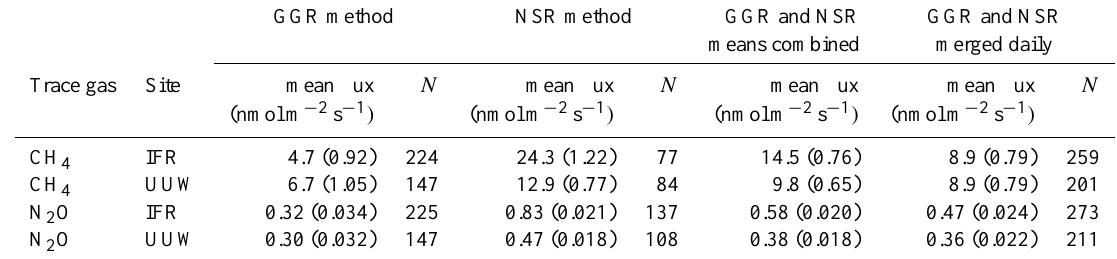
Table 3. Estimates of mean annual fluxes, for the period 17 August 2012 to 16 August 2013, from four approaches: GGR method, NSR method, mean of the annual means of GGR and NSR, and annual mean of daily values obtained from merging the two methods. Numbers in parentheses are error estimates from propagation of daily standard errors. N is the number of nights